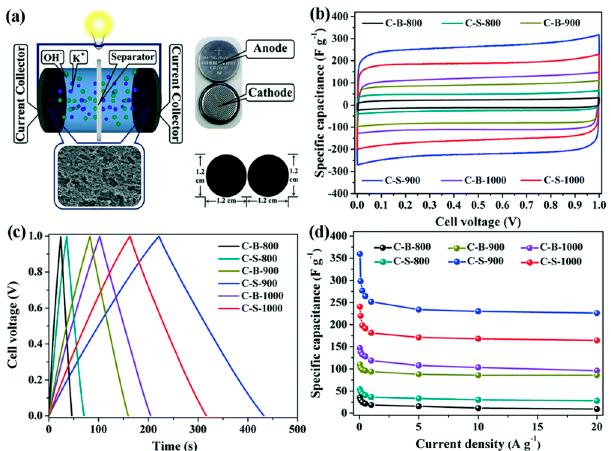
Figure 2. ( a ) Illustrations of the SSC in 6 M KOH electrolyte; ( b ) CV curves at 50 mV s − 1 for C-B-n and C-S-n; ( c ) Galvanostatic charge-discharge (GCD) curves at 0.5 A g − 1 for C-B-n and C-S-n; ( d ) dependence of specific capacitance on applied current densities [41].